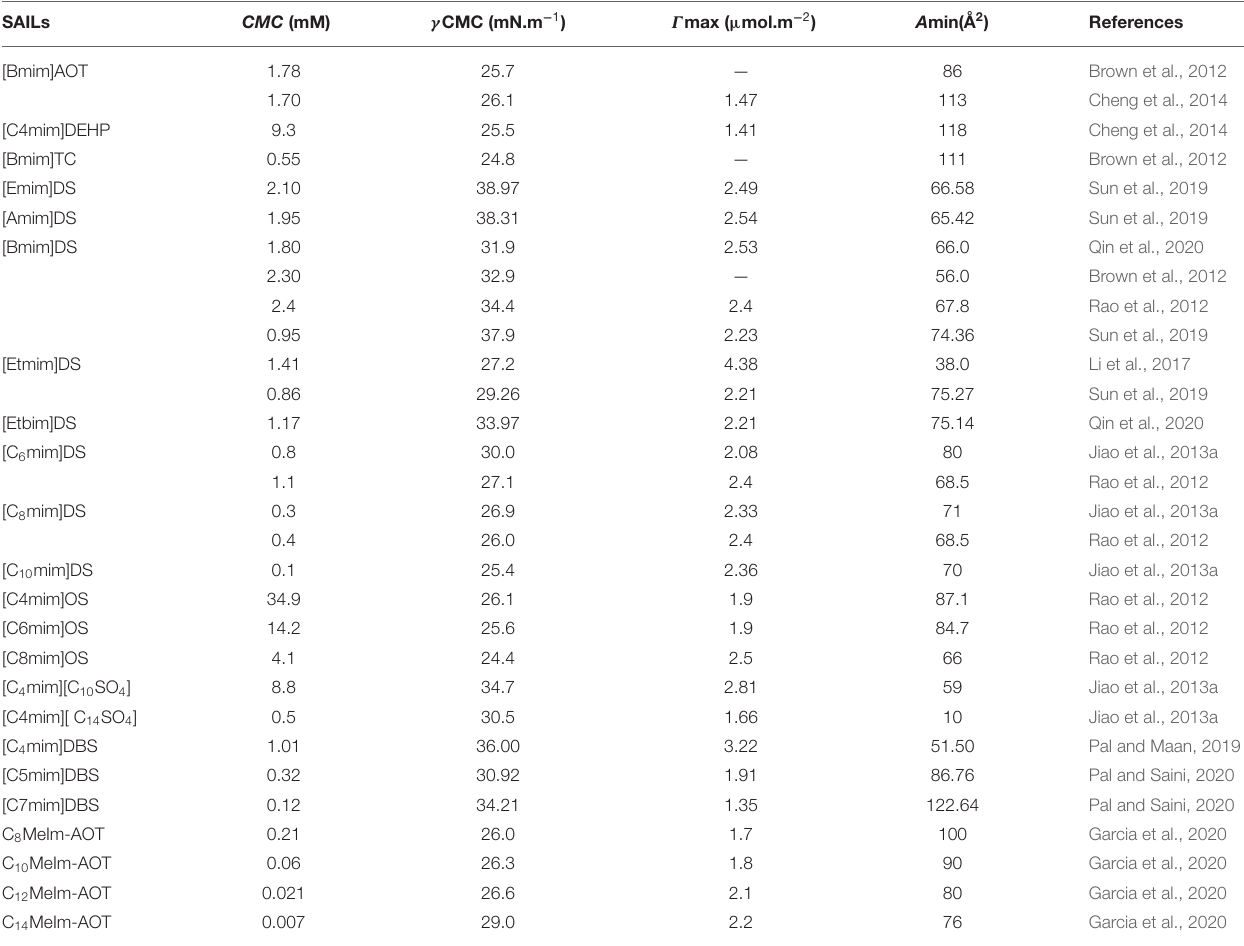
TABLE 1 | Reported values of critical micelle concentration (CMC), the surface tension at CMC ( γ CMC), surface excess concentration ( Γ max), and minimum area per molecule at air–water interface ( A min) for anionic surface-active ionic liquids (ASAILs) and catanionic surface-active ionic liquids (CASAILs) at 298.15K in aqueous medium.